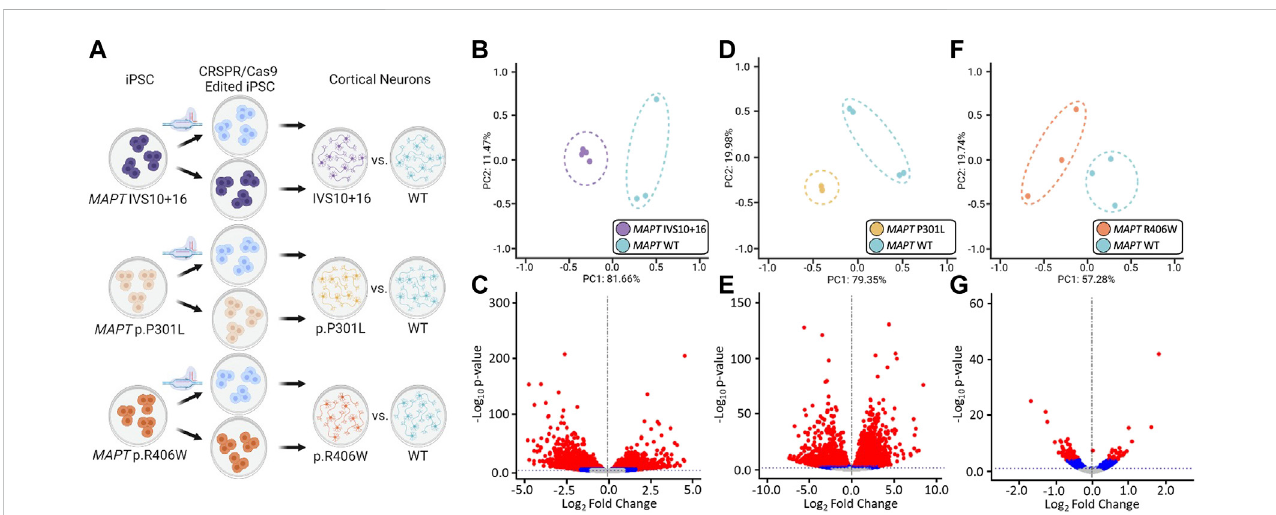
FIGURE 2 Global transcriptomic effects of MAPT IVS10 + 16, p.P301L, and p.R406W mutations. (A) Overview of iPSC differentiation into cortical neurons. (B – C) Principal component analyses and volcano plots obtained from MAPT IVS10 + 16 neurons compared to isogenic controls. (D – E) PCA and Volcano plots obtained from MAPT p.P301L neurons compared to isogenic controls. (F – G) PCA and Volcano plots obtained from MAPT p.R406W neurons compared to isogeniccontrols.PCAandVolcanoplotswerebasedon19,957protein-codinggenesusingregularized-logarithmtransformation(rlog)counts.Volcano plots showing log 2 fold change betweeniPSC-derived neurons carrying MAPT mutations vs. isogenic controls, and the – log 10 p -value for each gene. Red and blue dots within volcano plots represent, respectively, genes differentially expressed under adjusted-BY (BY-FDR) and unadjusted p -values ( p ≤